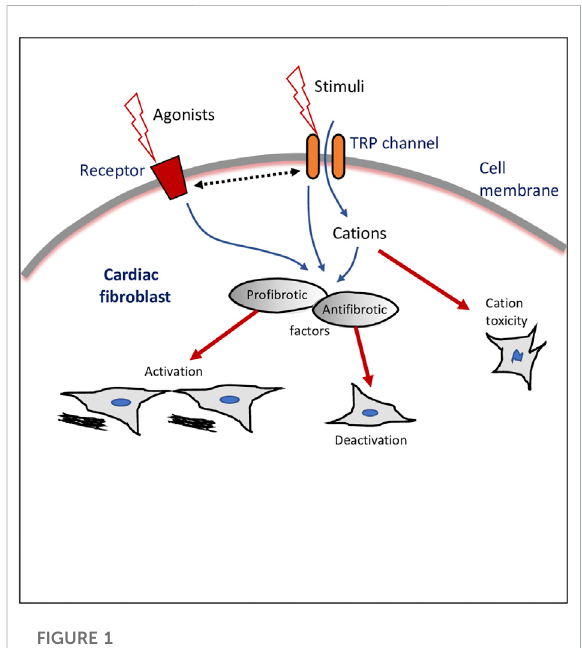
FIGURE 1 Transient receptor potential (TRP) ion channel modulation of cardiac fi broblasts. Schematic drawing of a cardiac fi broblast, external stimulants, and intracellular cascades and outcomes of TRP channels-mediated effects. Dotted line with double arrowheads depicts crosstalk or bi-directional